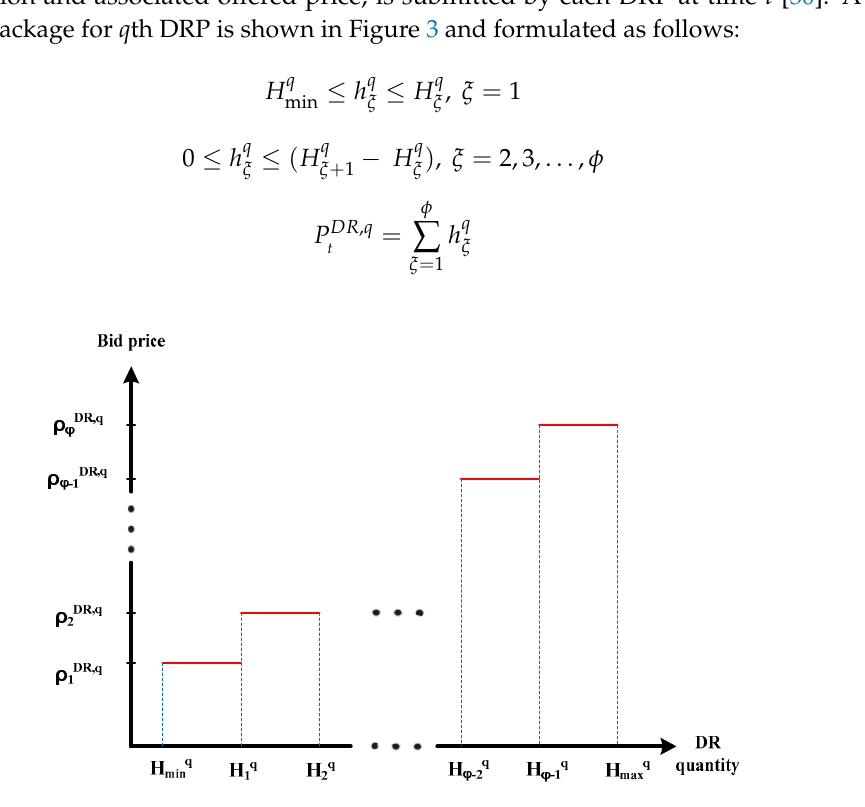
Figure 3. A typical bid-quantity package for q th Demand Response Provider (DRP).